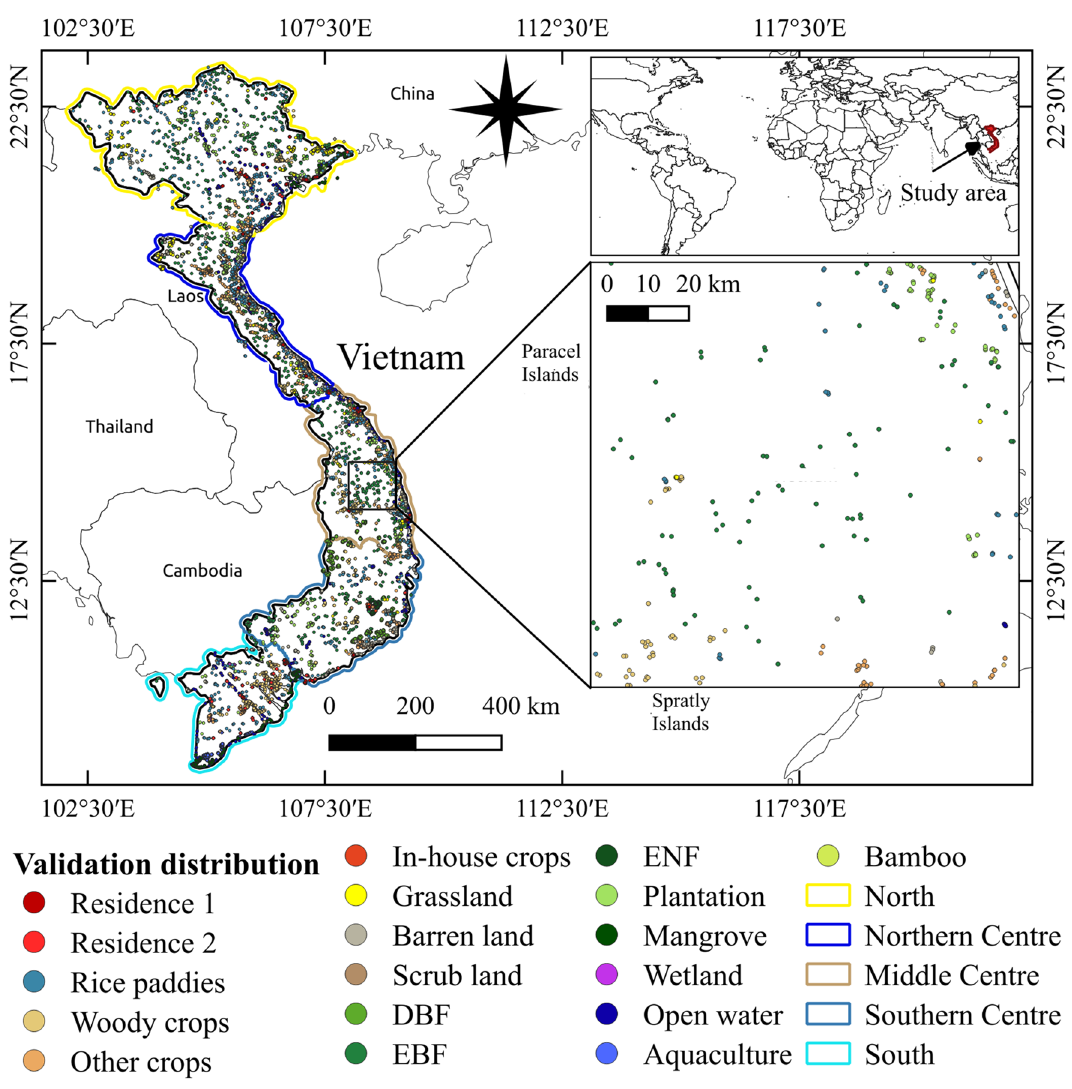
Figure 11. Location of mainland Vietnam in the world: major division zones ( bold lines ), distribution of validation data points across the country. These points are independent from the training data. This figure is generated using QGIS 3.18.0-Zurich (https:// qgis. org/ en/ site/) while the country boundary is extracted from the GADM (https:// gadm. org/ about.